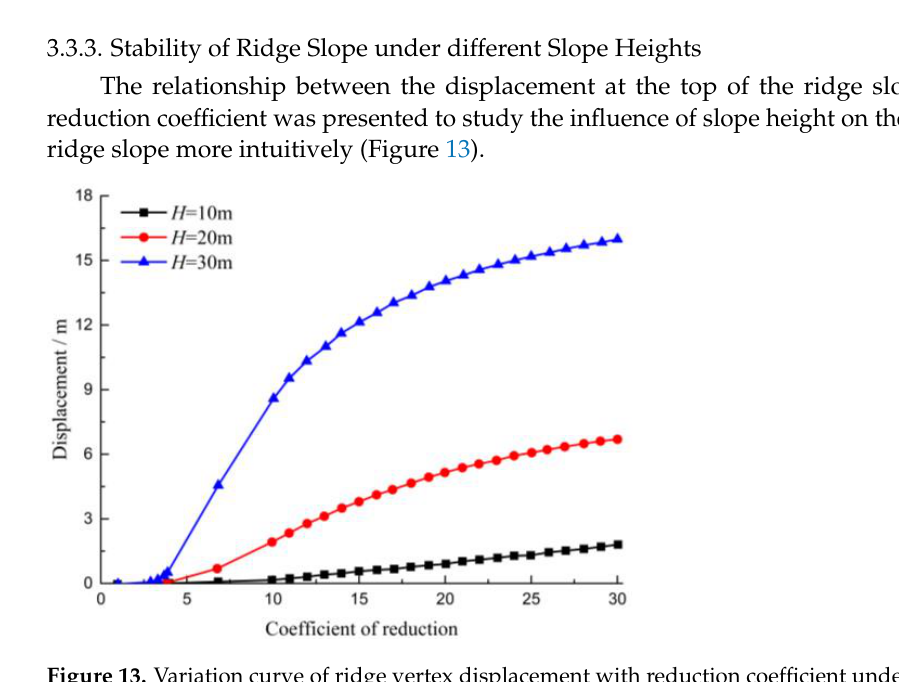
(c) Figure 12. The plastic zone cloud map of ridge slope under different slope heights; ( a ) H = 10 m; ( b ) H = 20 m; ( c ) H = 30 m. Figure 12 shows that the larger the height of the ridge slope, the larger its plastic area, and the plastic strain was also increasing. When the height was small, the plastic zone mainly occurred at the back edge of the slope, easily cracking the back edge. When the height of the ridge slope increased, a large plastic zone appeared at the front of the slope, and the bottom of the flank slope was also displaced. When the slope of the ridge in- creased slowly, the maximum plastic strain of the slope occurred at the top of the slope